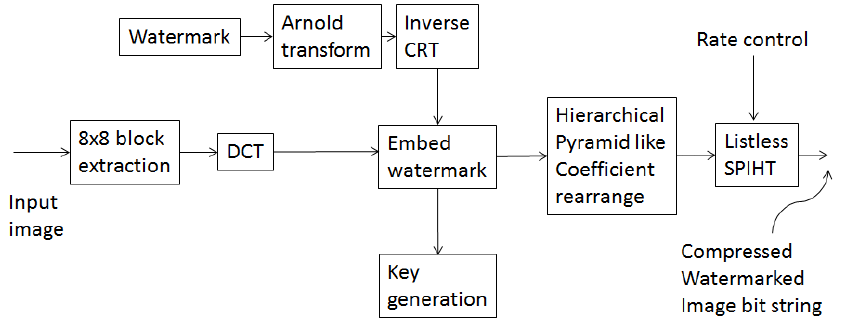
Figure 1. Watermark embedding process; DCT: discrete cosine transform; CRT: Chinese remainder theorem; SPIHT: set partitioning in hierarchical